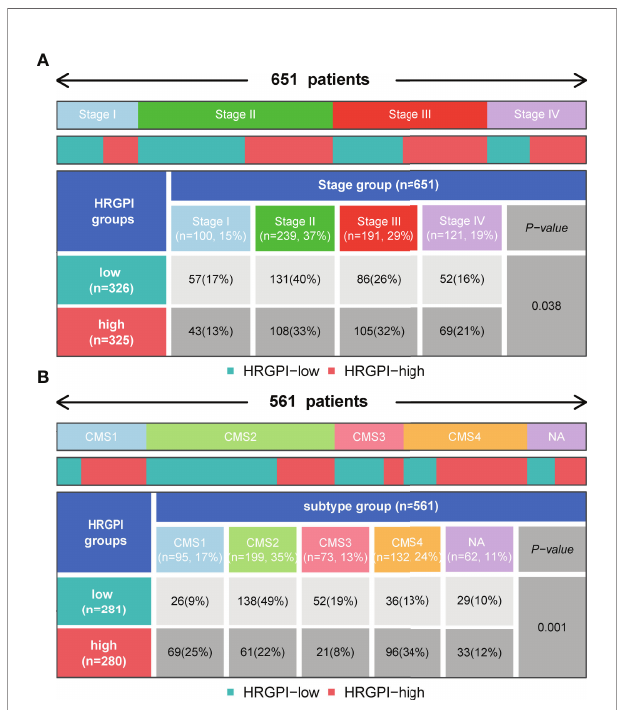
FIGURE 7 | Distribution of clinical-stage, molecular and immune subtypes in different HRGPI groups. (A) Heatmap and table showing the distribution of clinical stage in different HRGPI groups. (B) Heatmap and table showing the distribution of CMS subtypes in different HRGPI